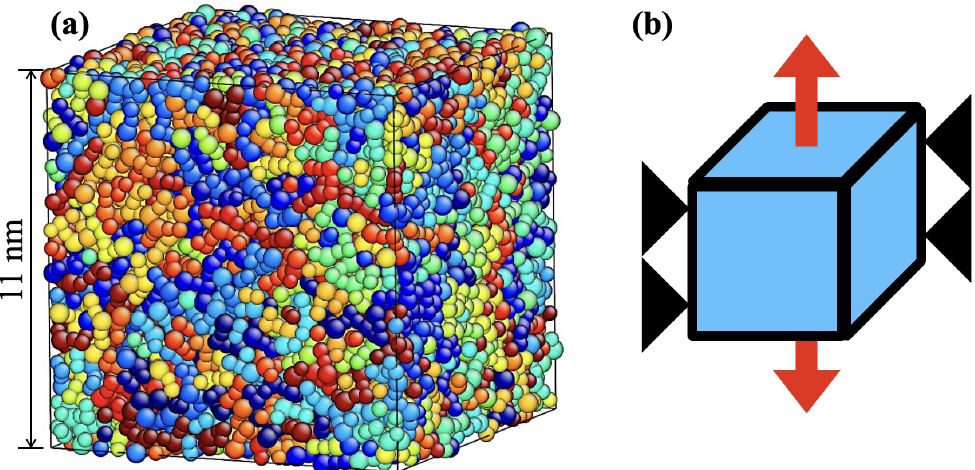
Figure 5. ( a ) Simulation cell before deformation. ( b ) Schematic representation of uniaxial deformation under transverse constrained